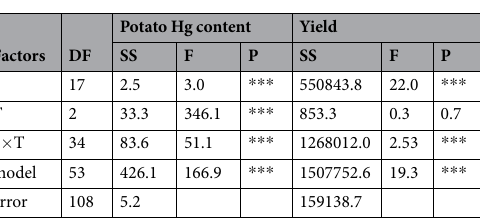
Table 3. A two-way ANOVA of the effects of soil type (S) and treatment (T) on potato edible part Hg content and yield. *** p < 0.001